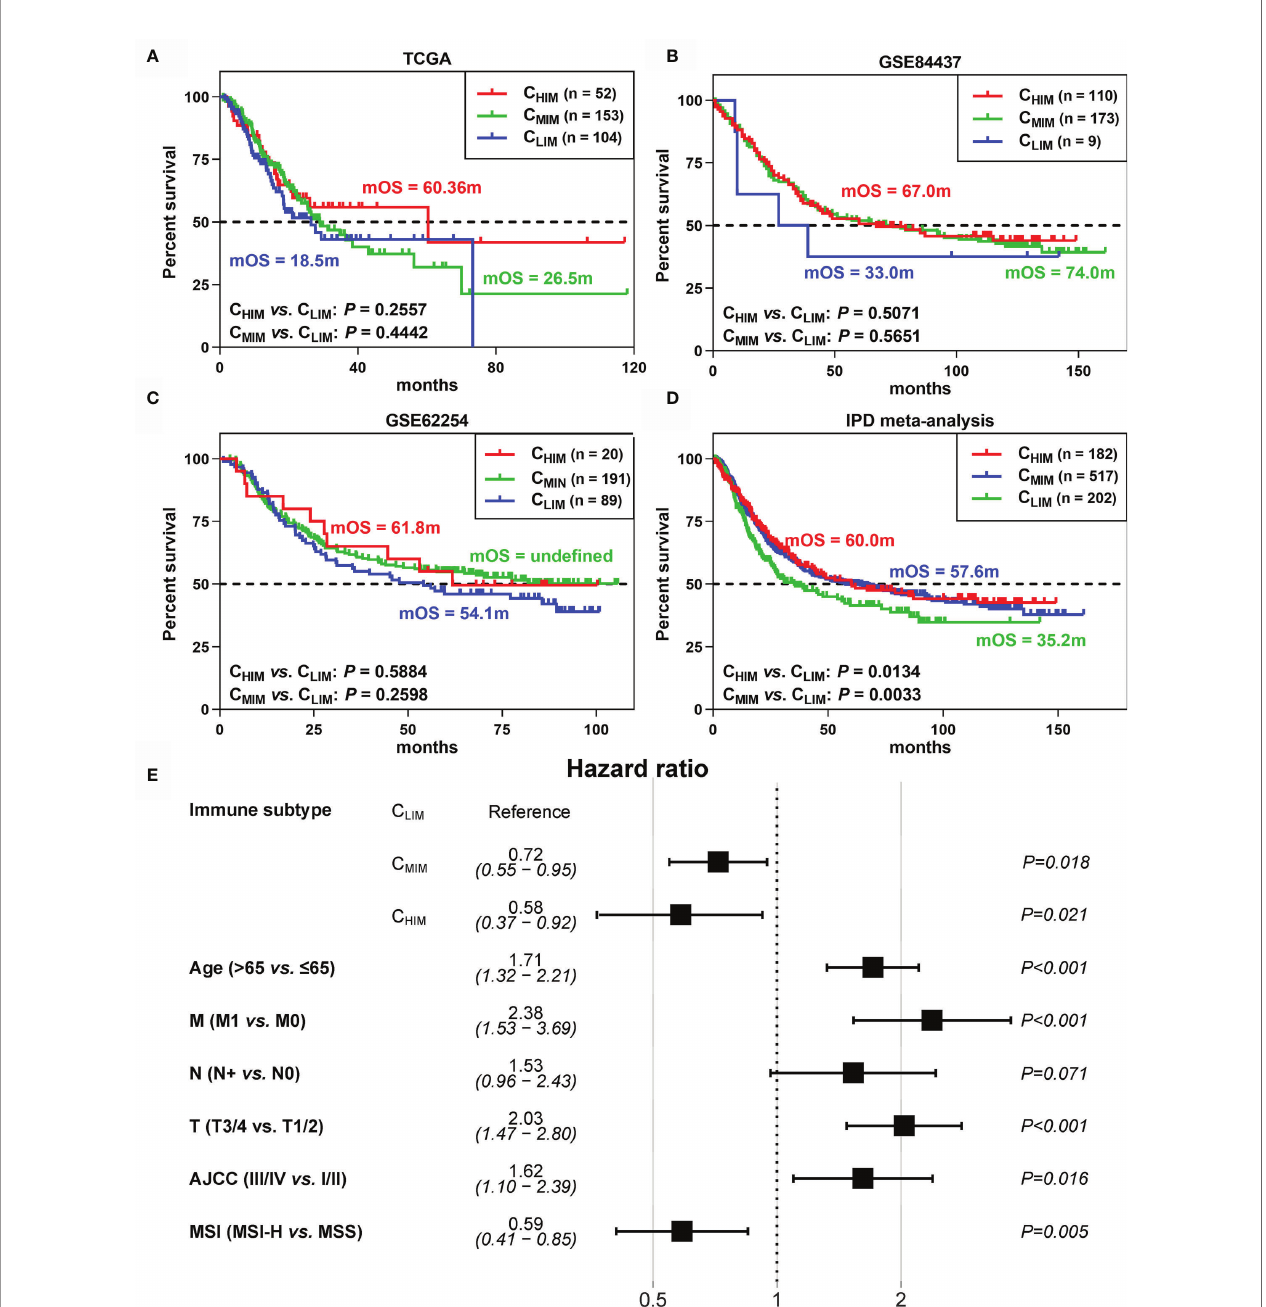
FIGURE 3 | Differences in survival between immune subtypes. (A – C) Kaplan-Meier curves of survival data in patients of 3 subgroups from TCGA (A) , GSE62254 (B) , and GSE84437 (C) datasets. (D) Kaplan-Meier curves of survival data in the combined cohort by individual patient data (IPD) meta-analysis. (E) Hazard ratios of clinical factors by multivariable COX